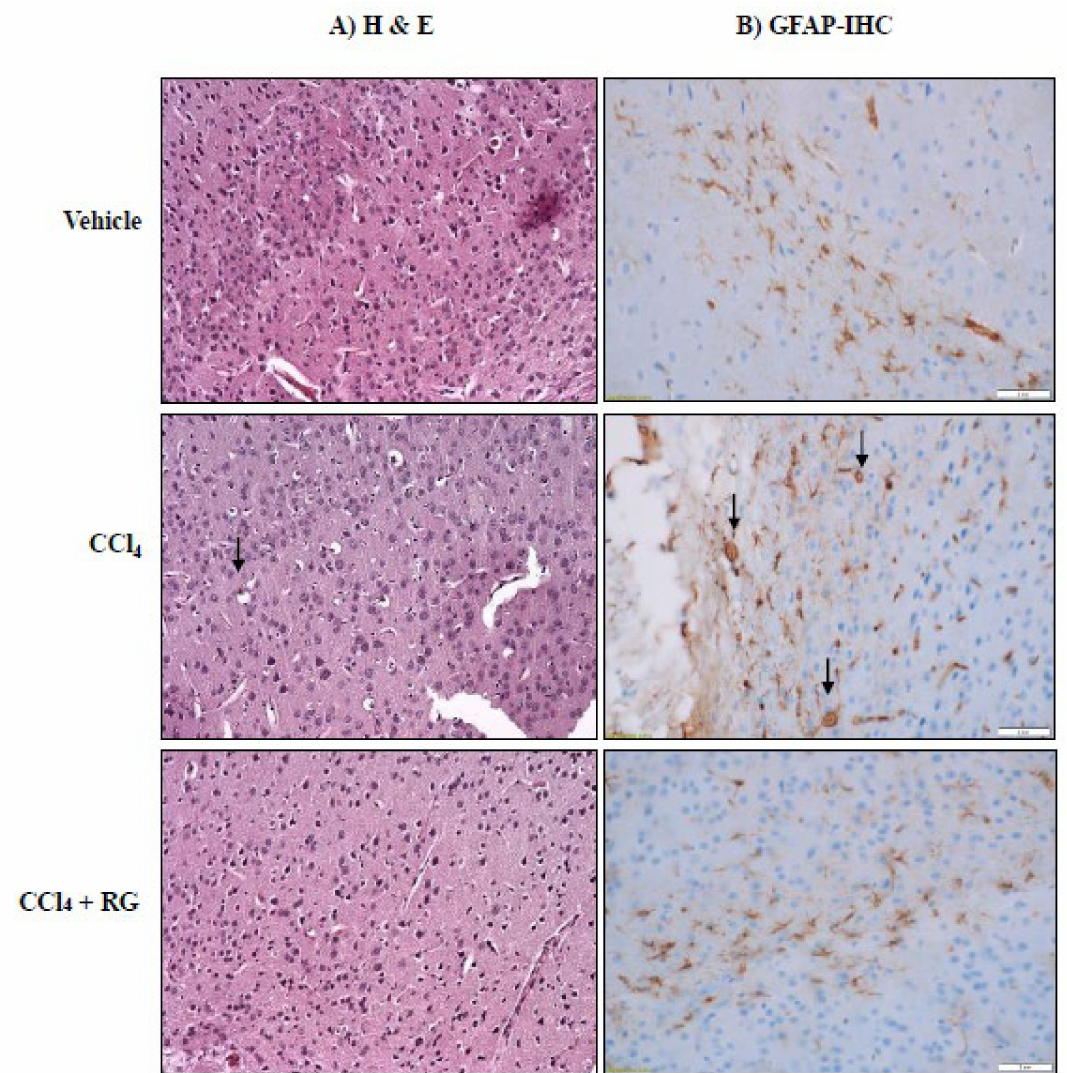
Figure 4. RG ameliorates CCl 4 -induced histological changes in cerebral cortex. Mice were given with repeated injections of CCl 4 (5 mg / kg, 2 times / week, 4 weeks), whereas vehicle mice instead received saline ( n = 4). The CCl 4 + RG group was treated with RG (10 mg / kg of R plus 100 mg / kg of G) with CCl 4 . After four weeks of CCl 4 injection, mice were sacrificed. ( A ) Histopathological change (when stained with hematoxylin and eosin; H&E) and ( B ) astrogliosis (glial fibrillary acidic protein, GFAP) in cerebral cortex. Magnification: 400 ×